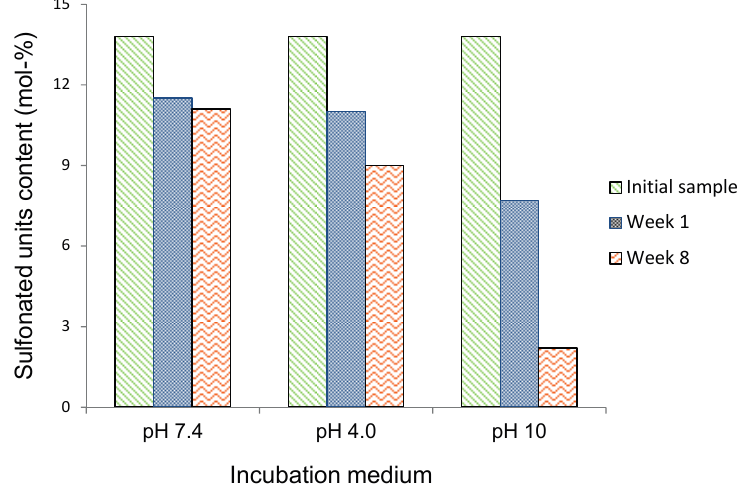
Figure 7. Evolution of the content in sulfonated units of the residual PBS 85 SS 15 along incubation